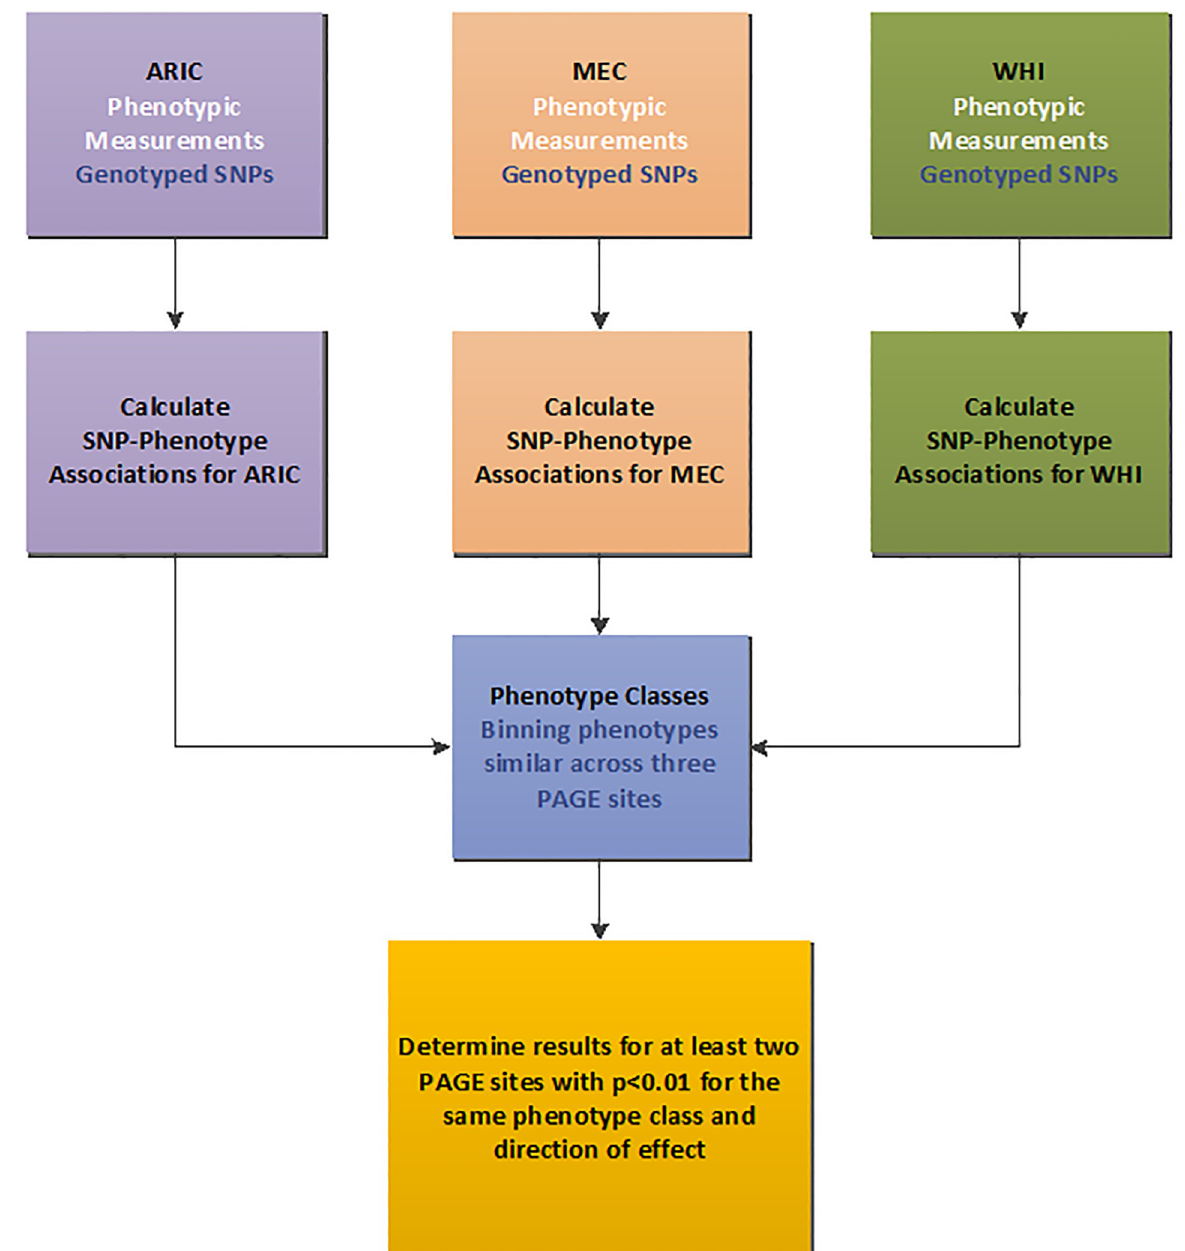
Fig 1. Overview of the Metabochip PheWAS study. Three different PAGE study sites contributed data to the project: Atherosclerosis Risk in Communities (ARIC); the Women’s Health Initiative (WHI), and the Multiethnic Cohort (MEC). Comprehensive tests of association between 144,740 Metabochip SNPs and 273 phenotypes were calculated for African American participants from each of the three PAGE study sites. Similar phenotypes that were collected across the studies were binned into “phenotype classes”. Our PheWAS-significant criteria required an association at p < 0.01 in at least two PAGE study sites for the same phenotype class and direction of